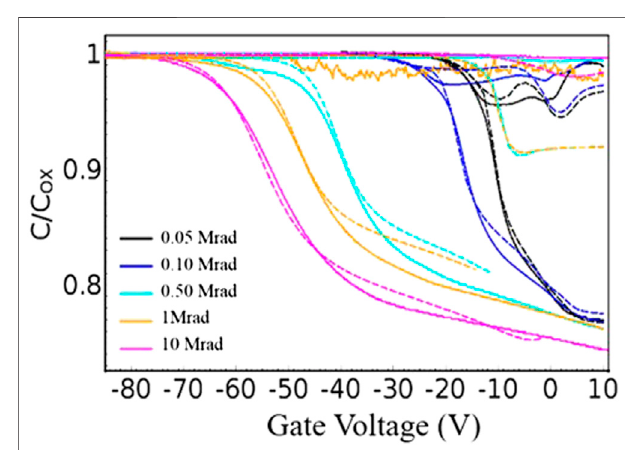
FIGURE 5 | C-V characteristics of HPK MOS capacitors: comparison between measurements and simulations (with p-spray isolation layer). Measurements in solid line and simulations in dashed